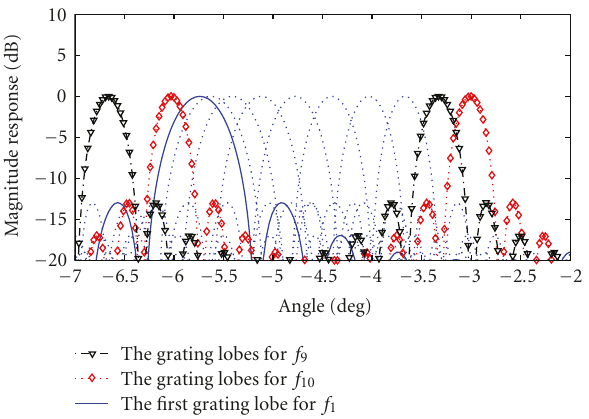
Figure 12: The di ff erent locations of grating lobes before combin- ing, Δ f = 268 MHz, L = 20 λ 0 /